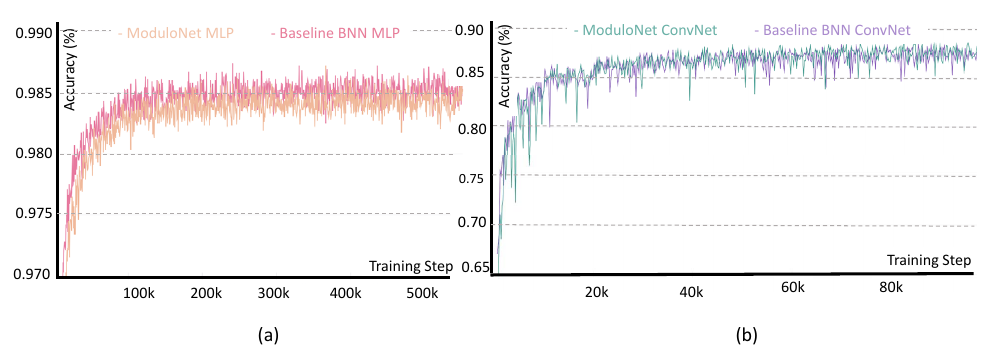
Figure 16: Test accuracy comparison of BNN with baseline vs. ModuloNET for (a) MLP-MNIST, and (b) ConvNet-CIFAR10 datasets. Vertical axis shows the accuracy in % while the horizontal axis displays the